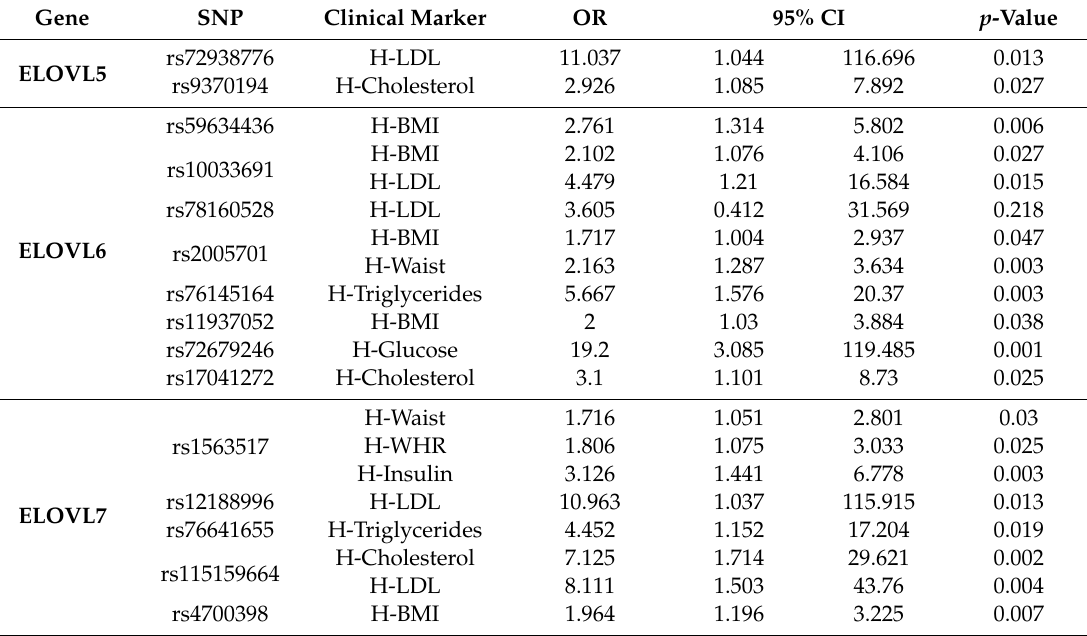
Table 6. Association of SNPs with clinical markers of chronic non-communicable diseases in women (risk factors). Gene SNP